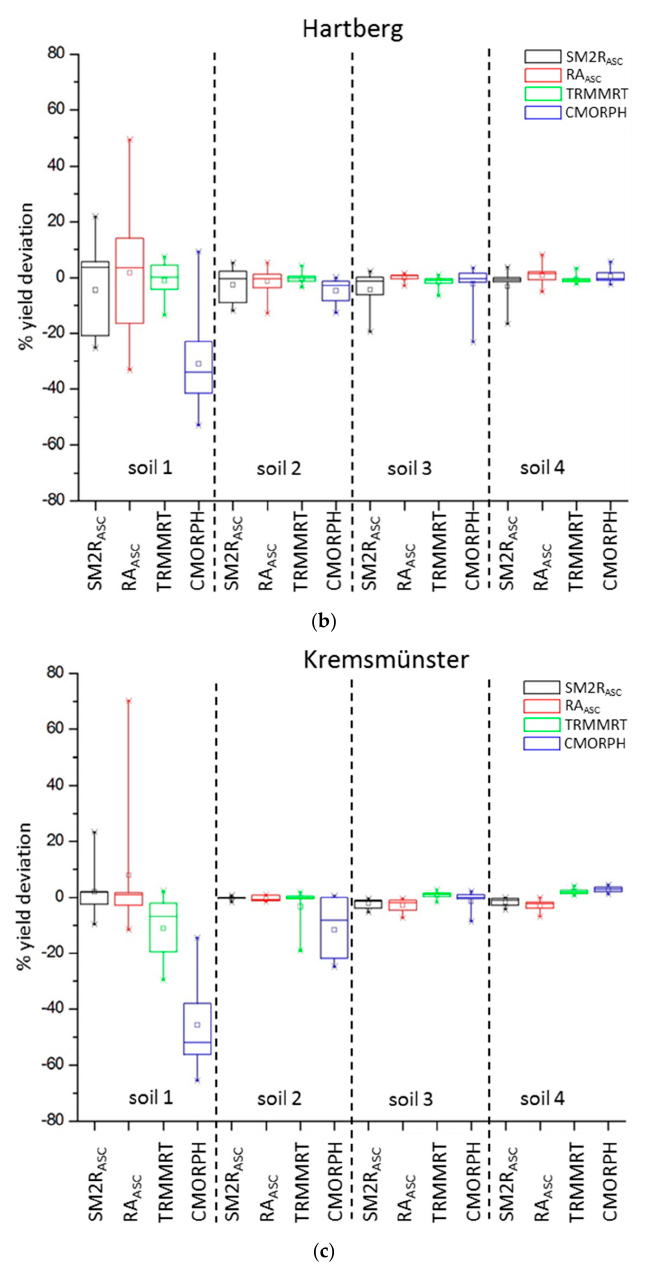
Figure 6. Boxplots of the relative differences [%] of winter wheat yield INCA 23km vs. SM2R ASC (black line), RA ASC (red line), TRMMRT (green line) and CMORPH (blue line) precipitation inputs in ( a ) Groß-Enzersdorf, ( b ) Hartberg and ( c ) Kremsmünster 2007–2015. The box lines represent the 25th, 50th and 75th percentiles, while the whiskers present the max and min values.